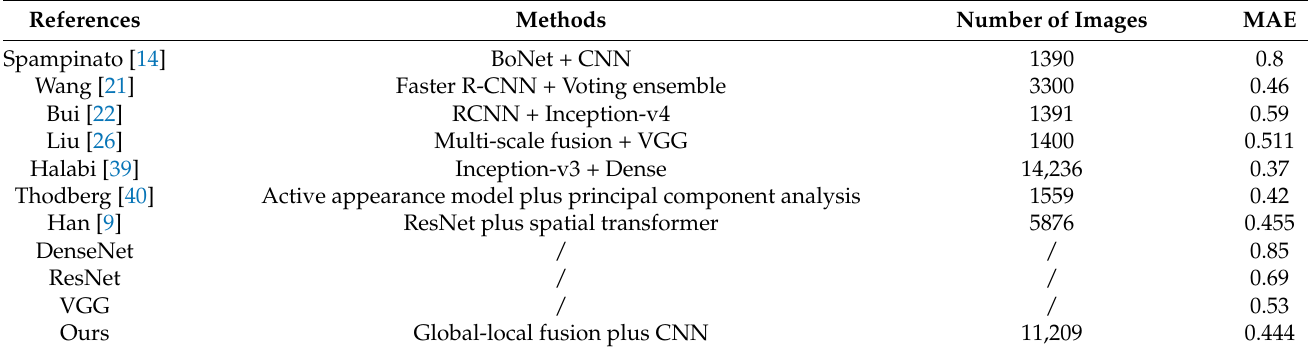
Table 5. Comparison in terms of average years between our method and state-of-the-art